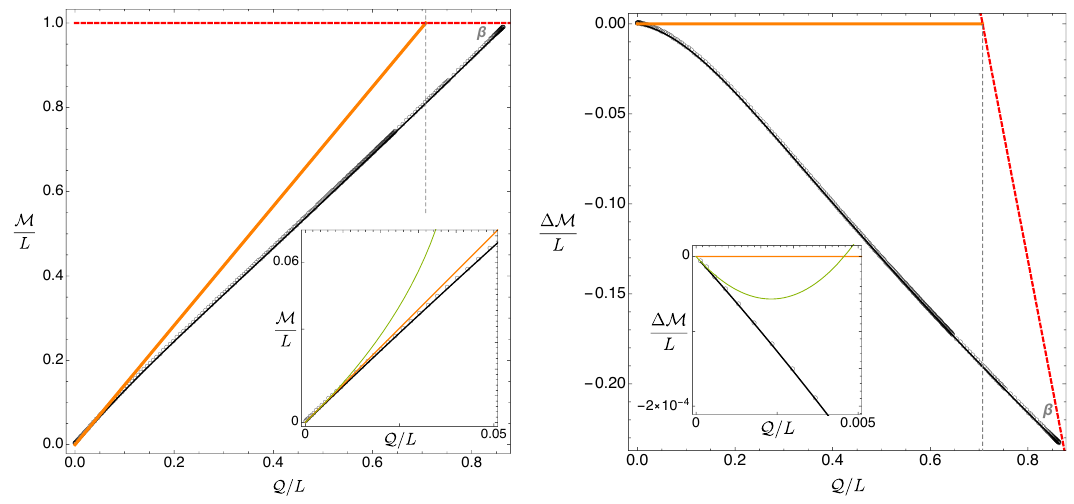
Figure 12 . Main soliton family with e = 2 . 3 ( e > e ). The soliton extends smoothly from the S origin to β and, unlike for e < e , the main soliton is now always less massive than its extremal S RN counterpart. This case also demonstrates better a claim that we made for other cases e : as the scalar condensate amplitude grows unbounded, (cid:15) → ∞ , the main soliton approaches point β in the red dashed line. As in other plots, the inset plots show the good agreement between the full result and the analytic prediction (green curve) at small